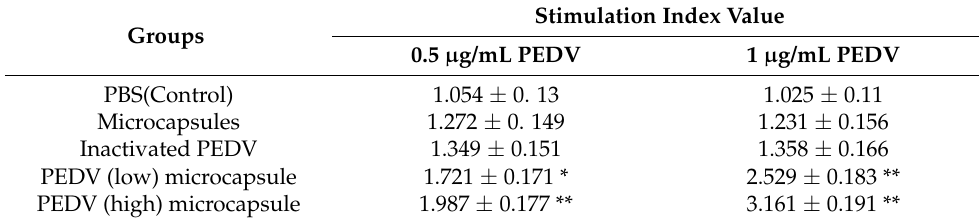
Table 2. Lymphocyte proliferation index.